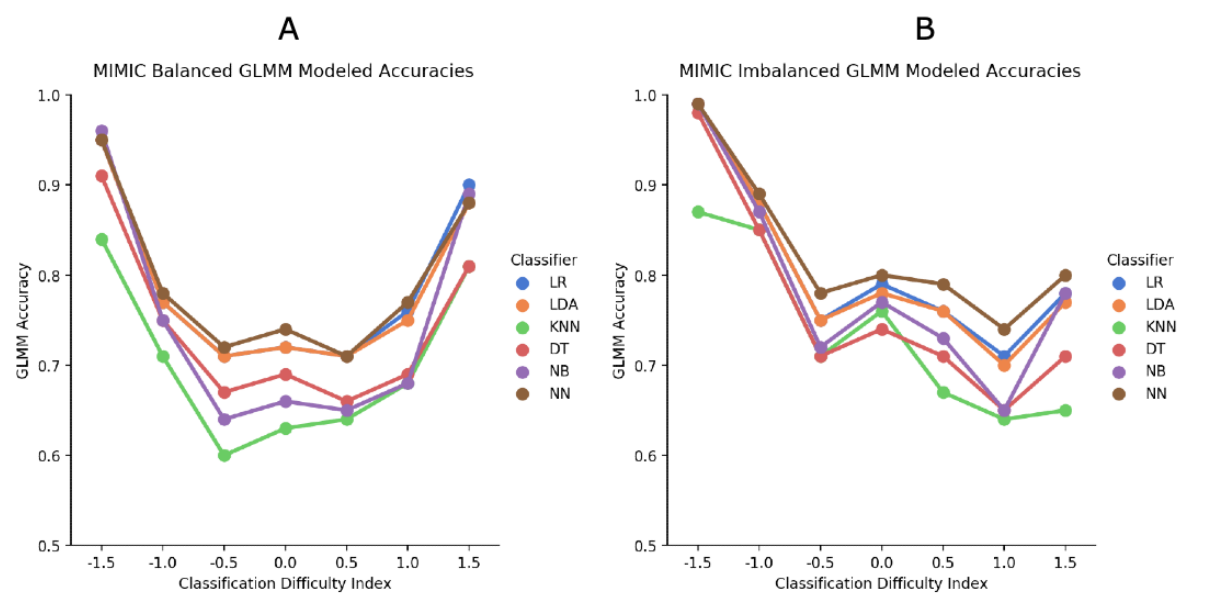
Figure 4. Medical Information Mart for Intensive Care (MIMIC) III generalized linear mixed model (GLMM) accuracy results; machine learning classifier against CDI for (A) balanced and (B) imbalanced data. DT: decision tree; KNN: K-nearest neighbors; LDA: linear discriminant analysis; LR: logistic regression; NB: naive Bayes; NN: neural